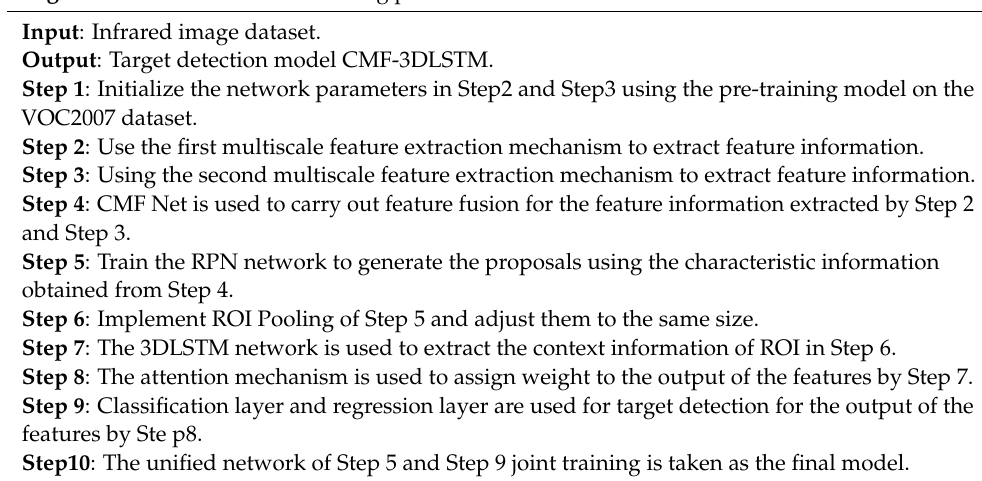
Algorithm 1: CMF-3DLSTM training